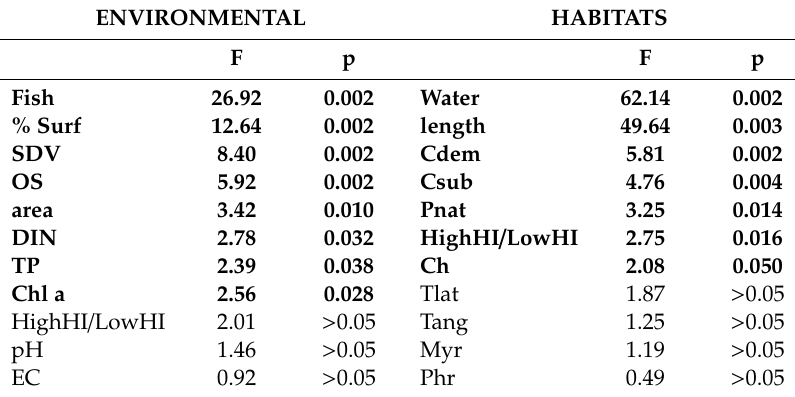
Table 2. Results of Monte Carlo test (F and p values given) of relationships between zooplankton indices and analyzed environmental / habitat factors in two types of ponds: HighHI ponds—anthropogenically modified ponds and LowHI ponds—ponds of low level of human impact (for legend see Table 1, Figure 2). Bold font – significant (p ≤